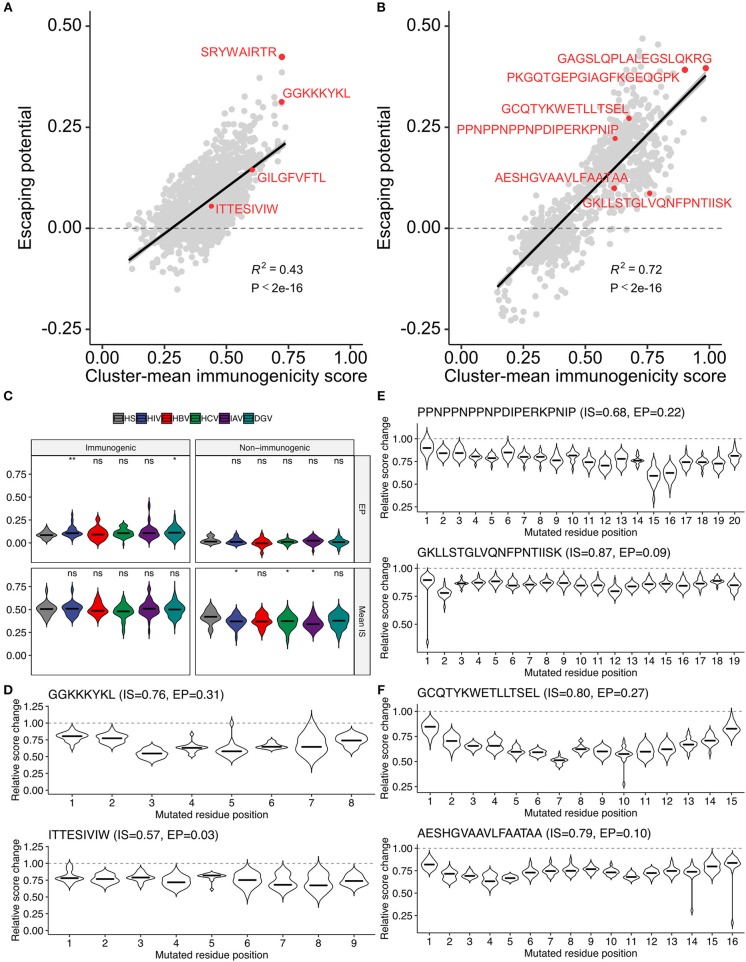
Two-dimensional assessment of epitope quality using the immunogenicity score and escape potential.(A,B) Immunogenicity score-escape potential (IS-EP) plots for (A) MHC-I and (B) MHC-II peptides. Cluster-mean immunogenicity scores determined from neighbor network analysis of all simulated neighbors were utilized. (C) IS and EP distributions among pathogen-derived peptides. ns, not significant; *P < 0.05; **P < 0.01. (D–F) Relative score changes estimated from all possible simulated neighbors for (D) representative MHC-I-restricted HIV epitopes, and (E,F) representative MHC-II-restricted epitopes derived from (E)
P. falciparum and (F)
M. tuberculosis. In (D–F), representative peptides were chosen based on their high and low EPs with manual literature inspection.